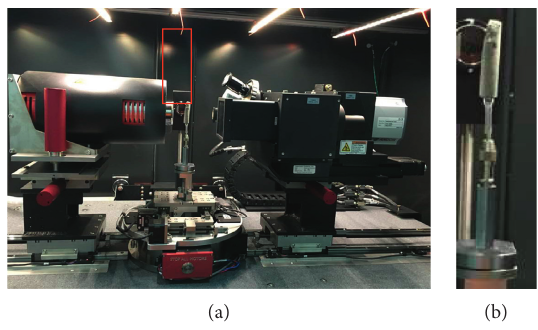
Figure 2: Photo of the micro-CT machine (a) and sample in the tube (b).